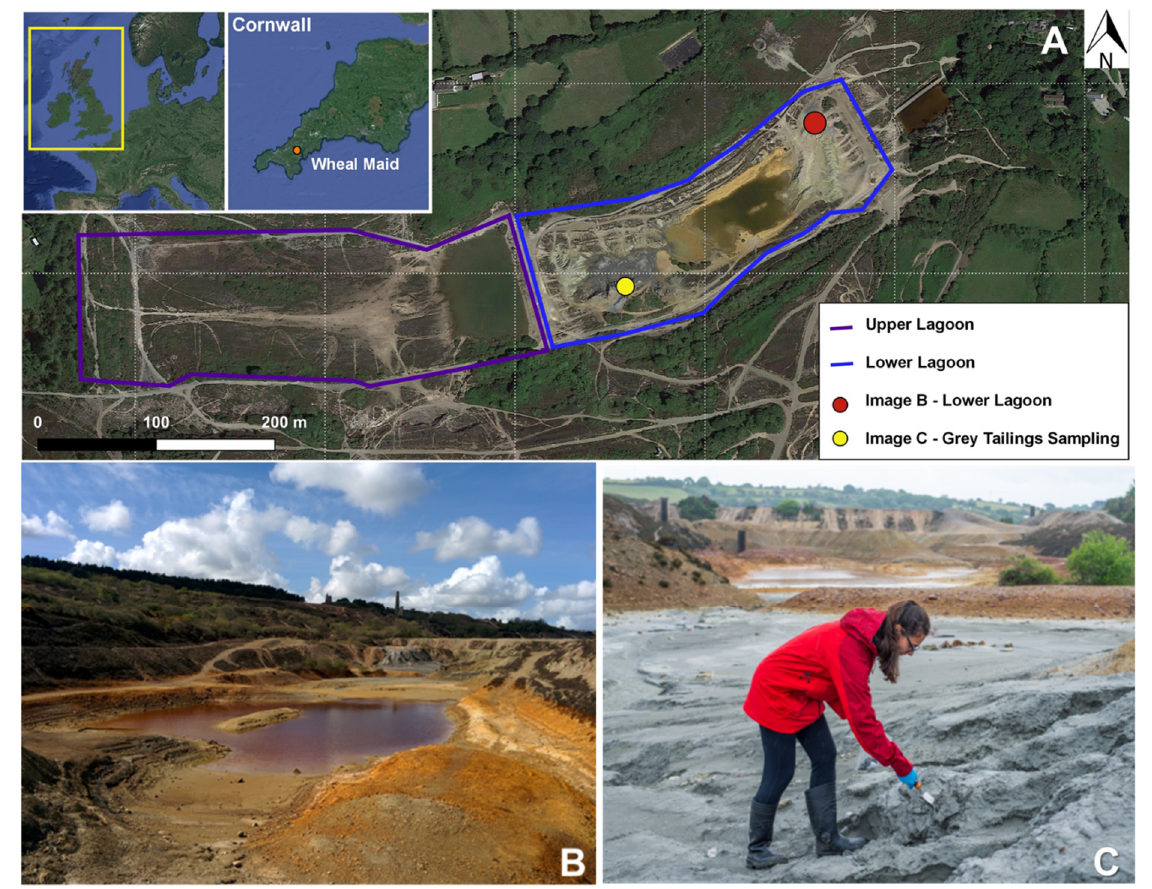
Figure 1. ( A ) Site location and layout. Grid Reference 50°14 ′ 15 ″ N 05°09 ′ 34 ″ W, showing the location of the site in Cornwall, UK and the tailings dam (upper lagoon shown in purple, lower lagoon in blue, location of 1B shown by red marker, location of 1C shown by yellow marker); images compiled in QGIS. ( B ) Photograph of the lower lagoon (R. Crane). ( C ) Photograph of sampling the Grey Tailings (C. Wilson, LLE Photography).